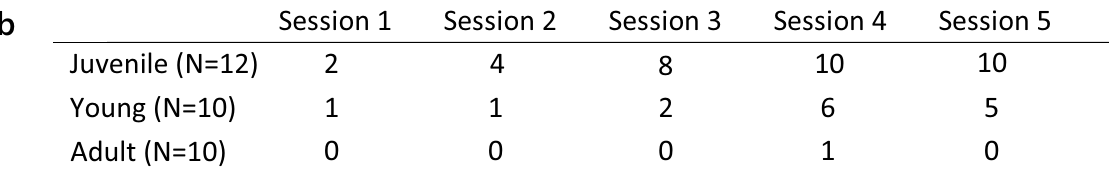
Figure 3. Strength of attack side preference at three developmental stages. ( a ) Proportion of left-side (red column) and right-side (blue column) attacks attempted by each predator (juveniles, J1–12; young, Y1–10; adults, A1–10). Red/blue and gray columns represent successful and failed predation attempts, respectively. Asymmetric mouth morphology—lefty ( L ) or righty ( R )—is denoted at the bottom. p -values were calculated according to the binomial test. * p < 0.05; ** p < 0.01; *** p < 0.001. ( b ) Number of individuals with significant bias in attack direction in Sessions 1–5 (binomial test, p <